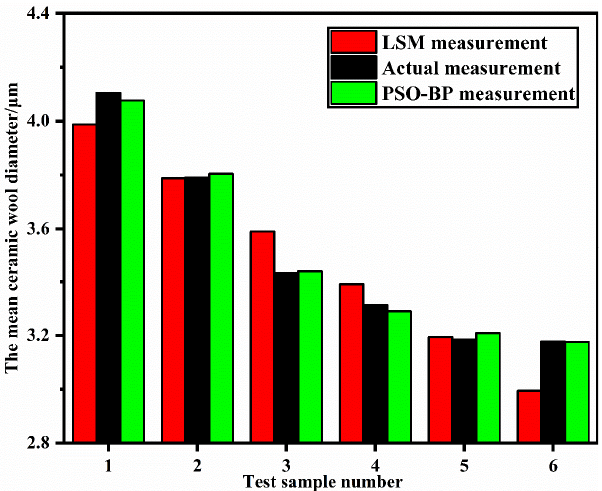
Figure 9. Comparison of measured and model predicted